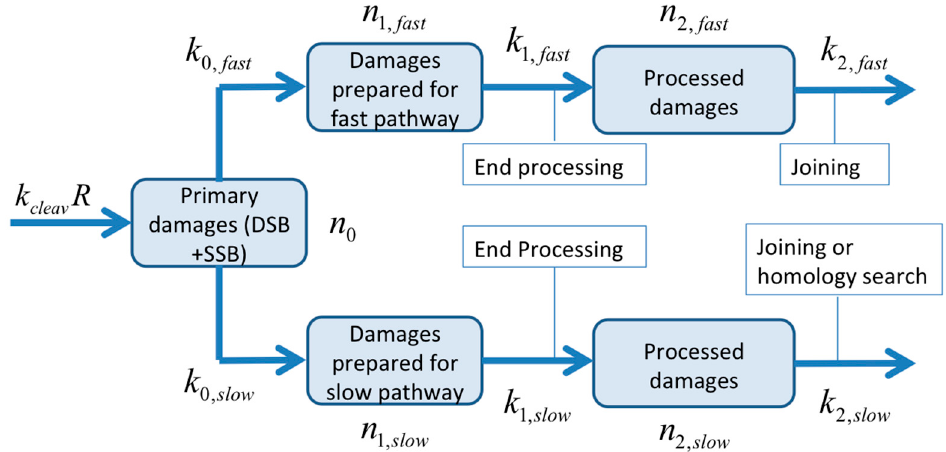
Figure 6. Process flow chart for the two-pathway model. Primary damages ( n 0 ) are detected by one of the two repair pathways and then transformed to damages prepared for the fast ( n 1, fast ) or slow ( n 1, slow ) pathway (by a first order kinetics). The damages are further processed and prepared for end-joining, or in the case of HR, homology search. Processed DNA fragments ( n 2, fast and n 2, slow ) fade away by the final repair step (second order kinetics). The full set of equations of the mathematical model is given in the supplementary materials.